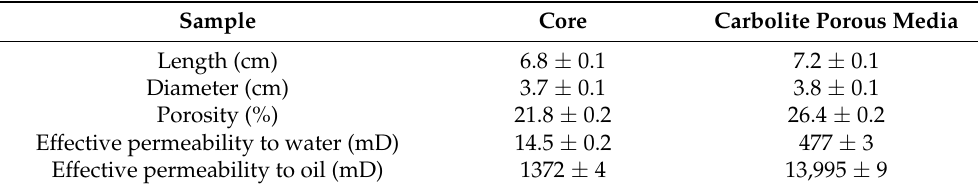
Table 1. Characteristics of the porous media representative of the reservoir and employed in the dynamic test.